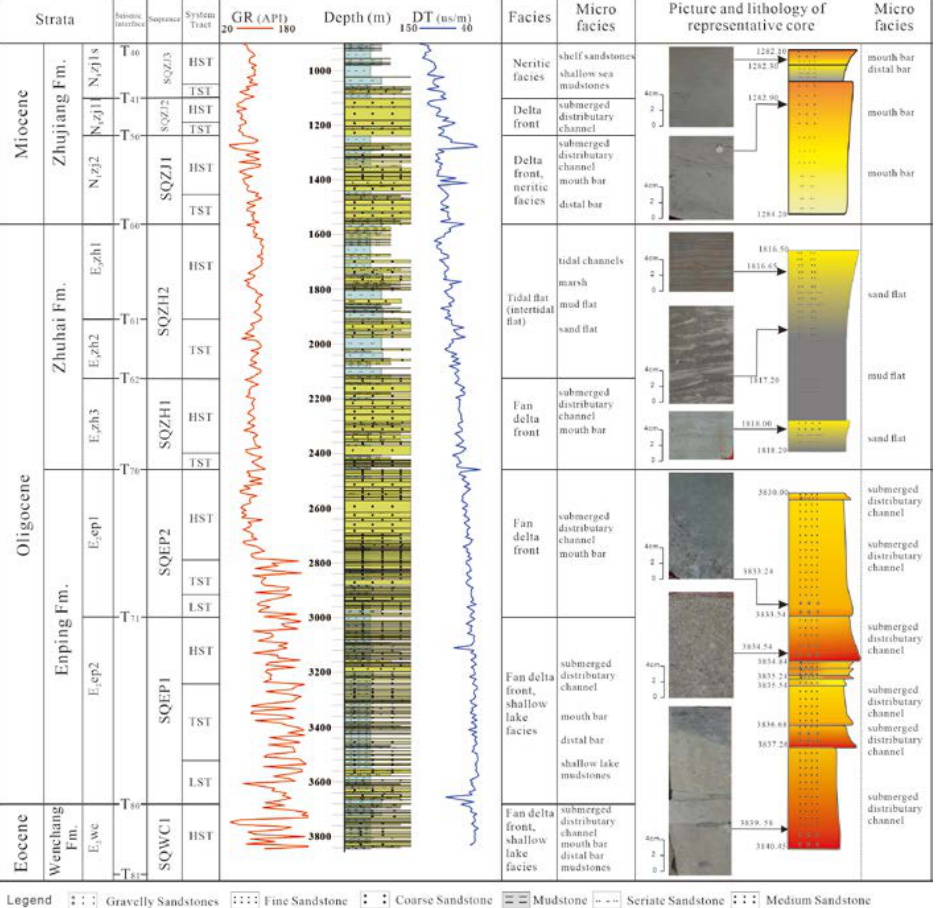
Figure 3. Drilling cores, logging, lithologic data, and interpreted depositional facies in Well A3 showing the depositional evolution from the Eocene to the Miocene. The location of Well A3 is shown in Figure 1.